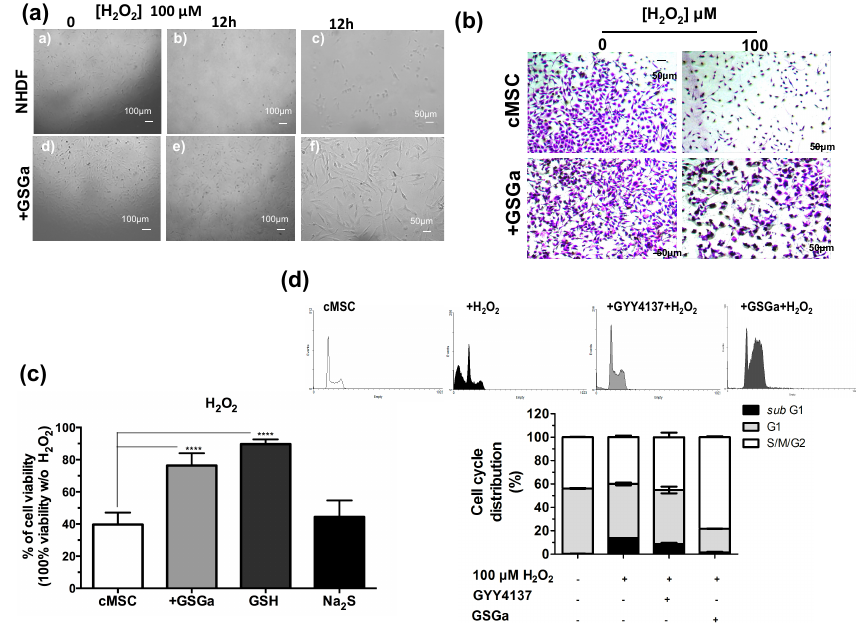
Figure 3. Antioxidant e ff ect of GSGa on cells. ( a ) Micrographs of NHDF after 0 and 12 h of treatment with H 2 O 2 (100 µ M), with ( + GSGa) or without (NHDF) the addition of 680 µ g / mL GSGa (see also Figure S5); (b ) micrographs of cMSC (CTRL) after 24 h of treatment with H 2 O 2 (100 µ M), with or without the addition of 680 µ g / mL of GSGa. Cells were dyed with crystal violet; ( c ) Cell viability of cMSCs after 24 h of growth in the presence of H 2 O 2 (100 µ M) (cMSC) (as control) and in the presence of 680 µ g / mL of GSGa ( + GSGa) or Na 2 S (95 µ M) or GSH (100 mM); ( d ) FACS cell cycle analysis of cMSC cultured for 24 h in the presence of H 2 O 2 (100 µ M) and with addition of either GYY4137 (80 mM) or GSGa (680 µ g / mL). Error bar indicates S.D. Experiments were performed in three or five biological replicas. **** p valule ≤ 0.0001 (one-way